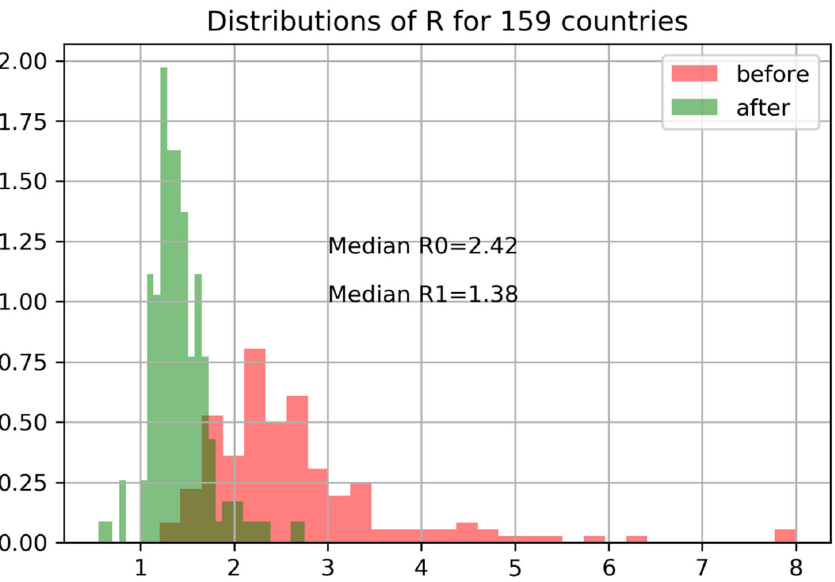
Figure 14. The distribution of R 0 and R 1 across 159 countries shows a steep decline in reproductive numbers following